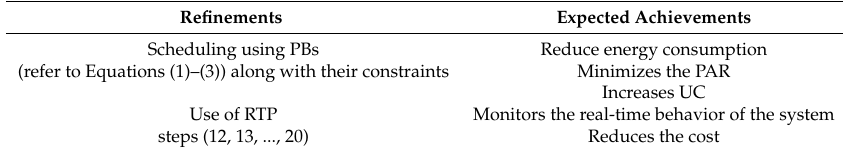
Table 7. Refinements in BFOA.